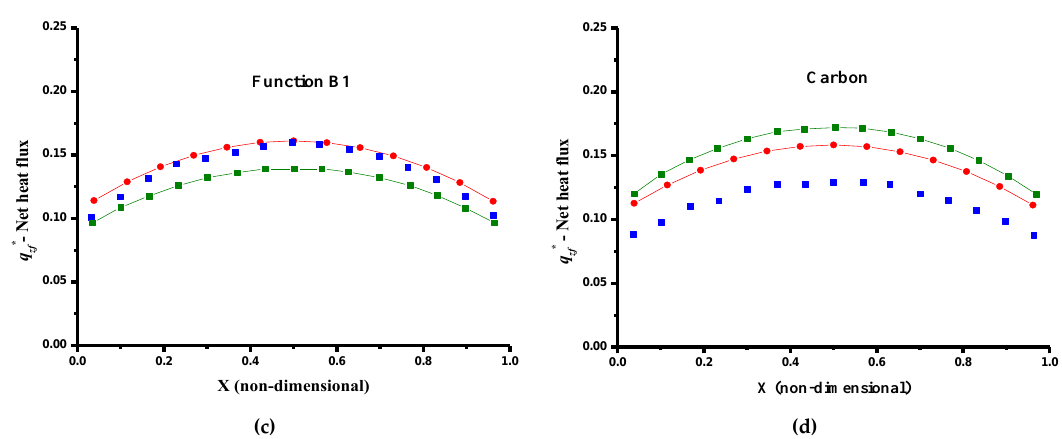
Figure 3. Dimensionless radiation heat flux density in z -direction at the middle of front cold wall (Y= 0.5, Z= 1.0).